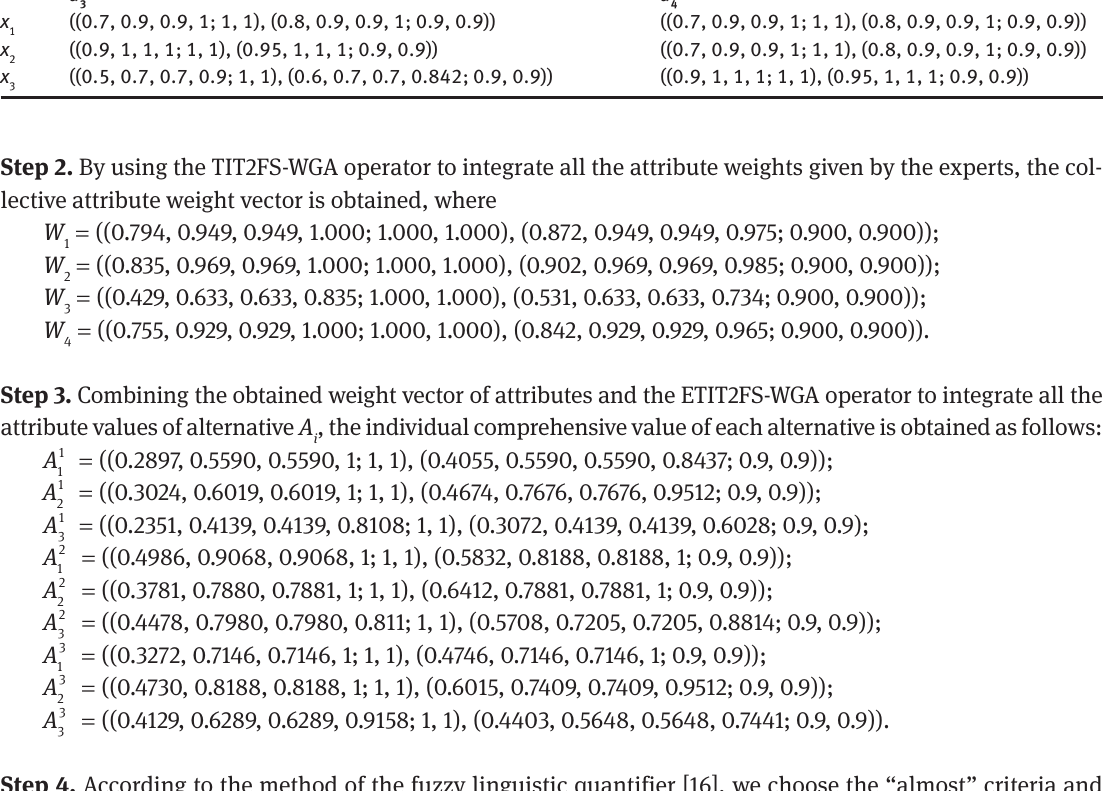
Table 6. Normalized Decision Matrix Given by Expert d